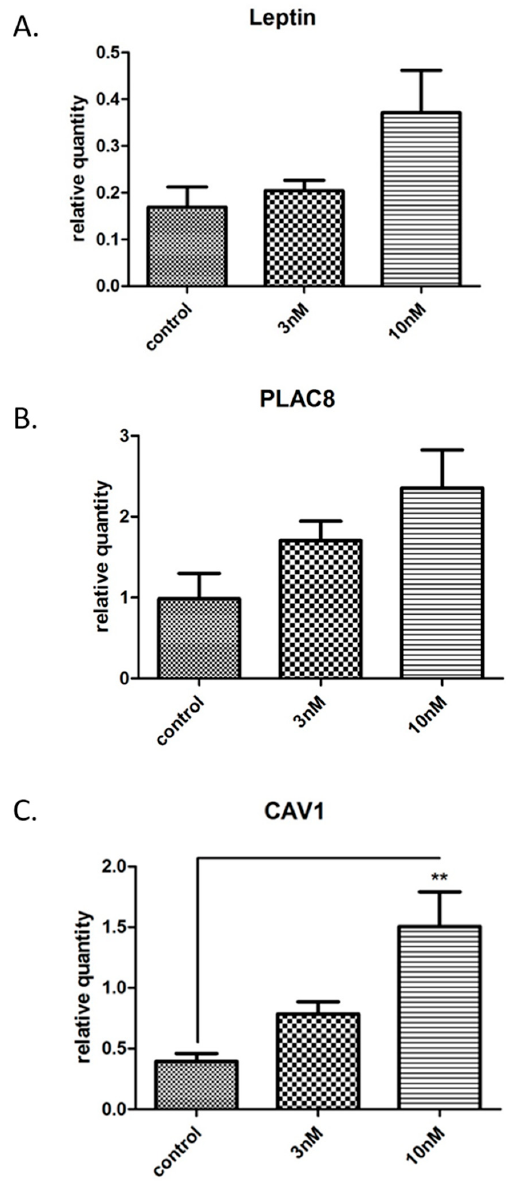
Figure 2. Validation of microarray data using qRT-PCR. ( A ). There was a relative increase in leptin gene expression when compared to controls after 10 nM bisphenol A (BPA) treatment. This is in accordance with the fold-change di ff erence (2.22) between untreated BeWo cells and 10 nM BPA-treated BeWo cells found in microarray analysis; ( B ). There was a notable increase in Placenta-specific 8 (PLAC8) gene expression when compared to controls after 3 nM and 10 nM BPA treatment. This is in accordance with the fold-change di ff erence found between untreated BeWo cells and 3 nM BPA-treated BeWo cells (1.75), as well as between untreated BeWo cells and 10 nM BPA-treated BeWo cells (2.14); ( C ). There was a significant increase in Caveolin-1 (CAV1) when comparing untreated BeWo cells to 10 nM BPA-treated BeWo cells ( p < 0.01). This is in accordance with the fold-change di ff erence found between untreated BeWo cells and 3 nM BPA-treated BeWo cells (2.35), as well as untreated BeWo cells and 10 nM BPA-treated BeWo cells (3.55).